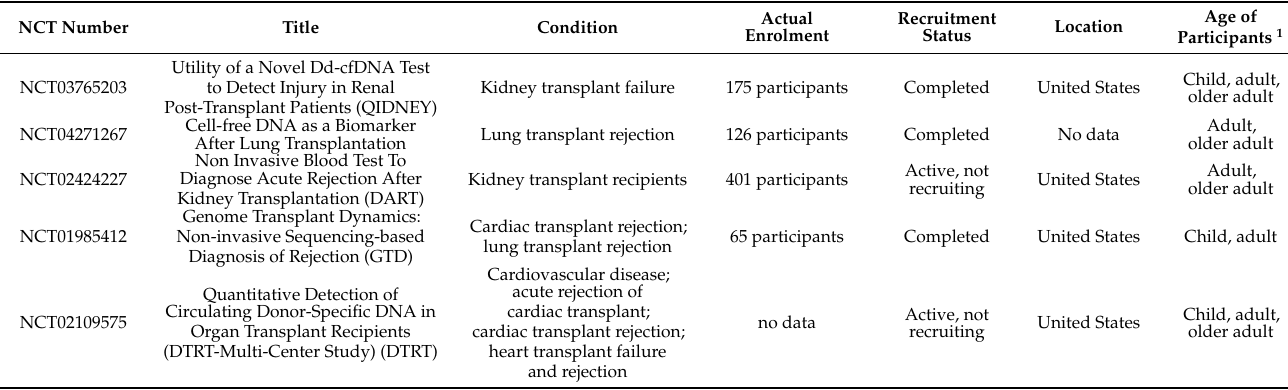
Table 2. The five clinical trials of cfDNA in transplantation downloaded from ClinicalTrials.gov database (https://clinicaltrials.gov/) with terminated, completed, and active, not recruiting status.